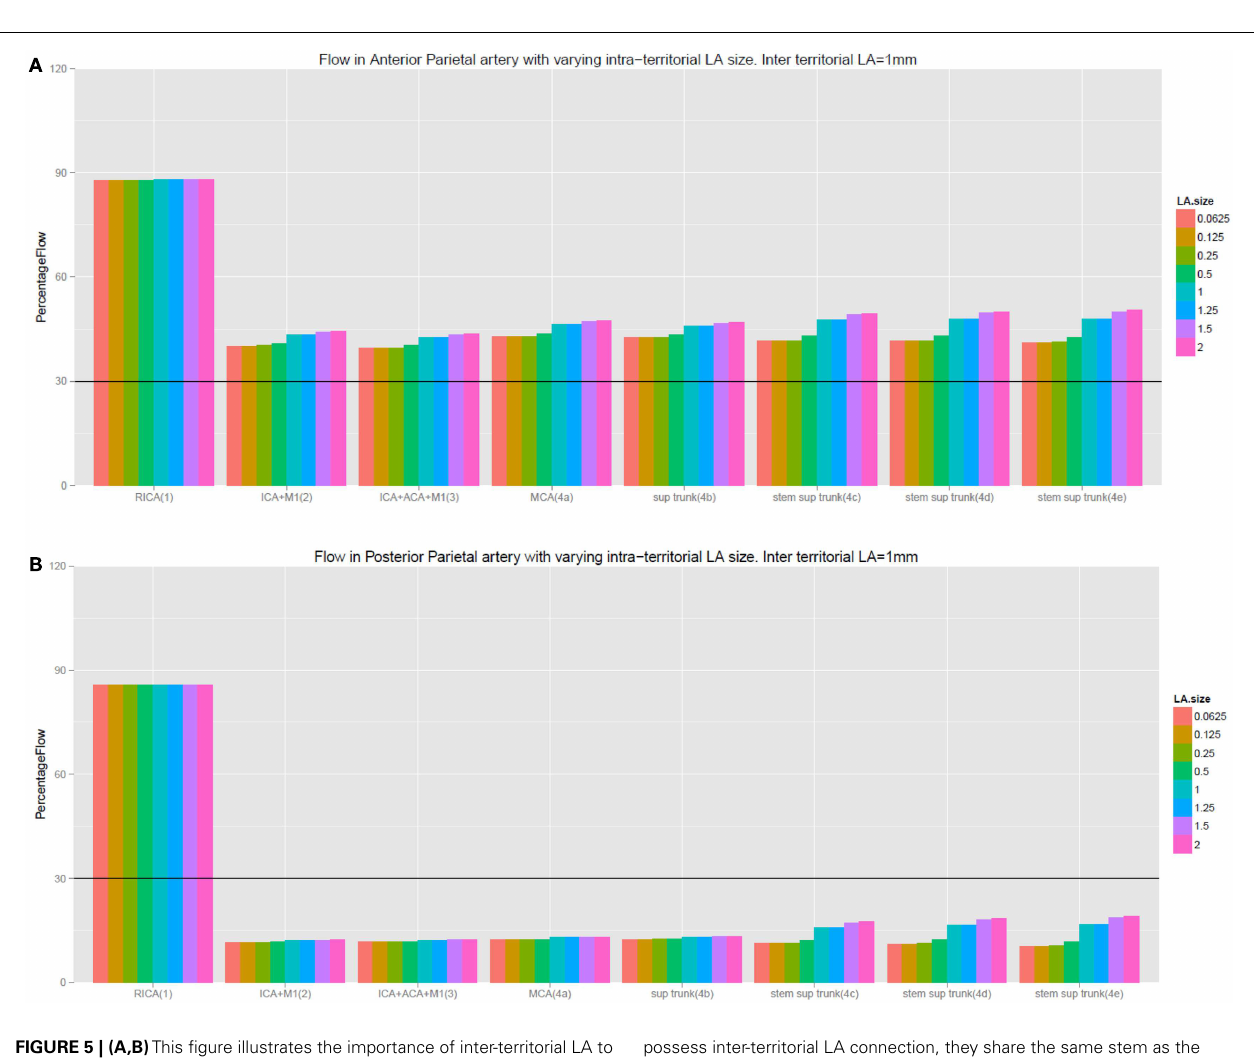
FIGURE 5 | (A,B) This figure illustrates the importance of inter-territorial LA to flow under the setting of intracranial occlusion. Observe the difference between Figure 4A (cortical artery with inter-terrorial LA) and (B) (cortical artery with no inter-terrorial LA). Although the prefrontal arteries do not